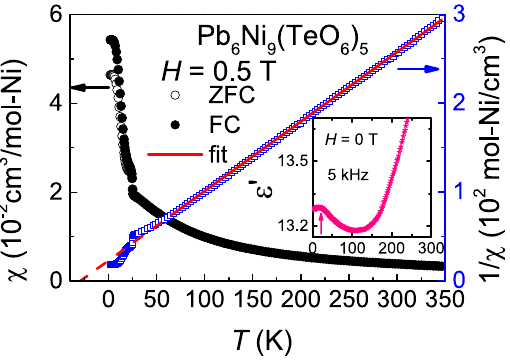
Figure 2. χ ( T ) measured in 0.5 T. The solid line is a fit to 1/ χ data, while the dashed line represents the extrapolation. Inset shows the ε′ ( T ) measured at frequency 5 kHz and 0 T.